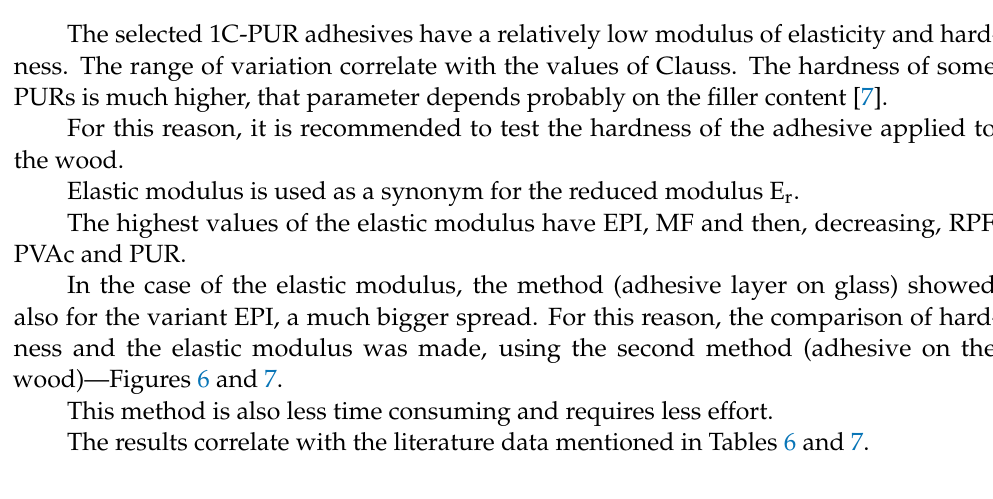
Figure 6. Comparison of the elastic modulus from the nanoindentation of the pure polymer films and polymers in the adhesive on the wood (error bars correspond to the standard deviation).